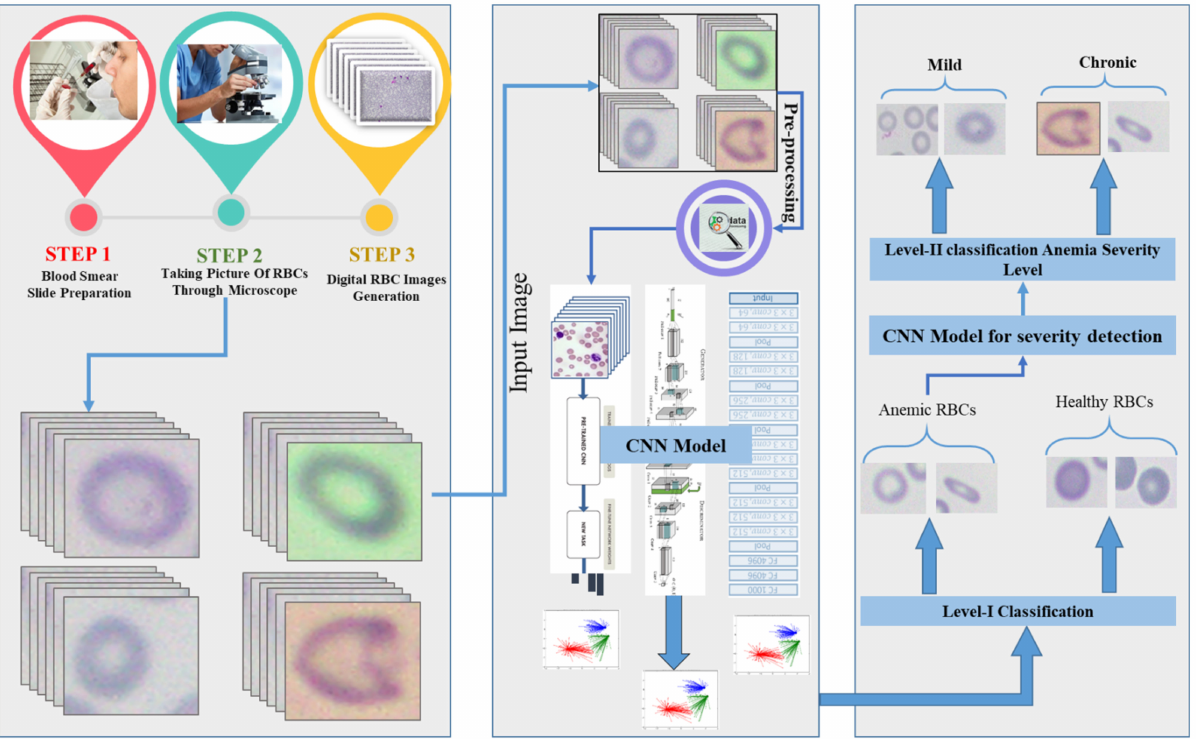
Figure 6. Illustration of proposed CNN-based model for two-level classification: Level-I classification categorizes the input images as healthy or anemic. Level-II classification identifies the severity of the anemic image as mild or